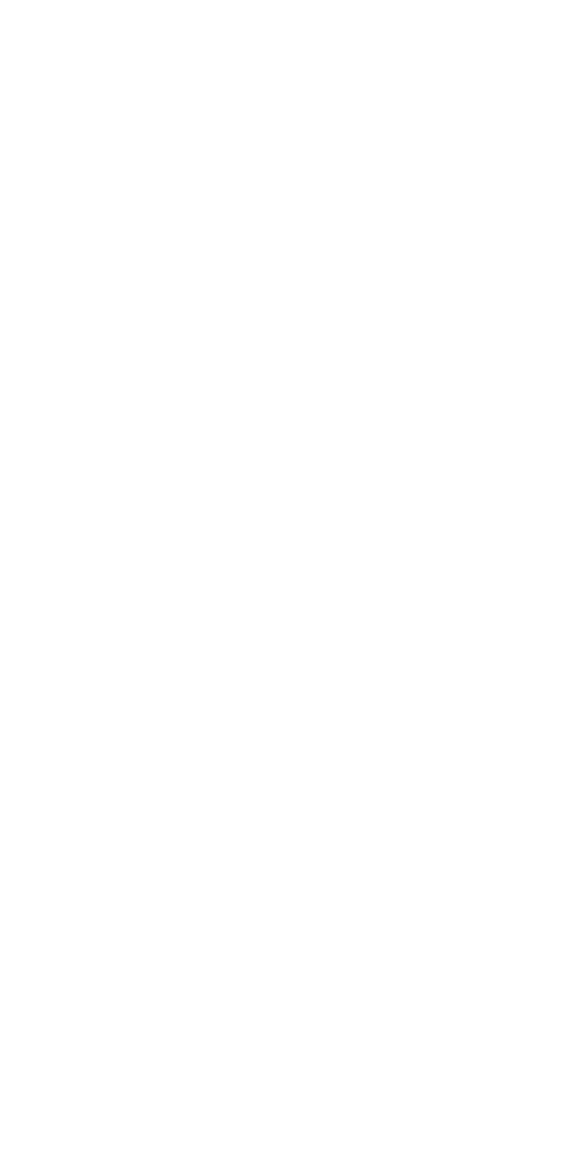
between motif start and RNA 5 (cid:2) end (left), the distance between motif end and RNA 3 (cid:2) end (middle), and the density of both (right).